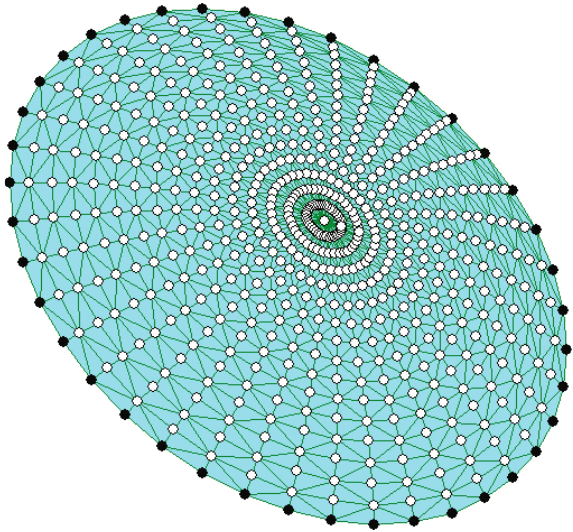
Figure 2: Finite element mesh. Table 2: Optimization parameters.